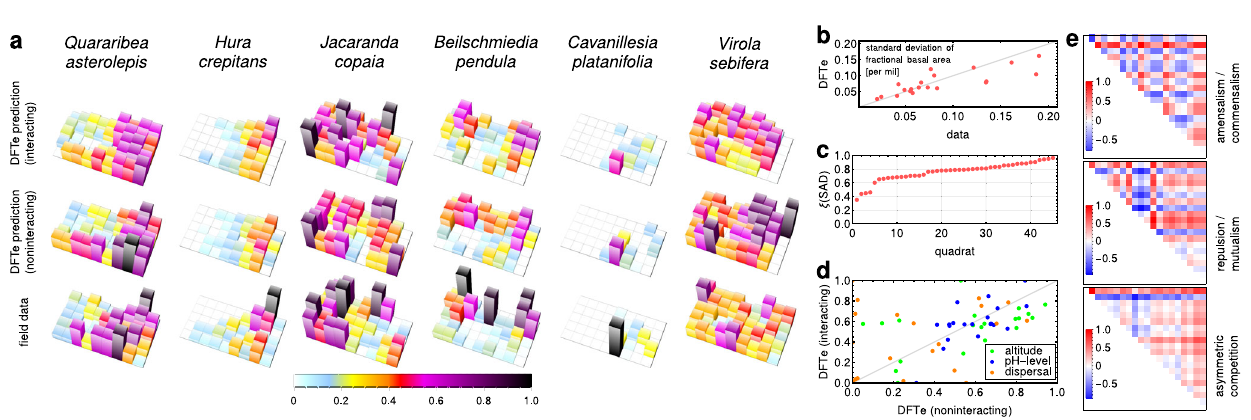
Fig. 7 | An application to the tropical-forest data from Barro Colorado Island three charts for each of the species shown ( s =1,4,8,12,16,20) we report the (cid:4) (cid:5) demonstrates the scalability of DFTe towards many-species systems. a We . Complementing measures of density values relative to max r ~ n s ð r Þ , ~ n 0 s ð r Þ , n ref s ð r Þ (cid:2) (cid:3) the quality of ~ n are the species-resolved variability in density ( b ) and the (sorted) obtained the DFTe densities ~ n s ~ n 0 s , which represent the spatially resolved frac- least-squares overlaps ξ of abundances N ( Q ) with N ref ( Q ), viz. the overlaps of local tional basal area of species s averaged over all available censuses 42 , in the top (centre)rowofchartsbysimultaneously fi ttingthegeneralDFTeenergyfunctional species-abundance distributions (SAD) for each of the 45 quadrats Q ( c ). d The fi t parameters associated with altitude, pH-level, and dispersal, with and without E with (without) inter-species interactions to the reference densities n ref s in the bottomcharts;seeMethods.Both ~ n s and ~ n 0 s areanadequate fi t( ξ ≈ 0.79)to n ref s for bipartite interactions. e , The fi t results for the bipartite interaction kernels (see Methods); each sub-panel is normalised to its respective maximum